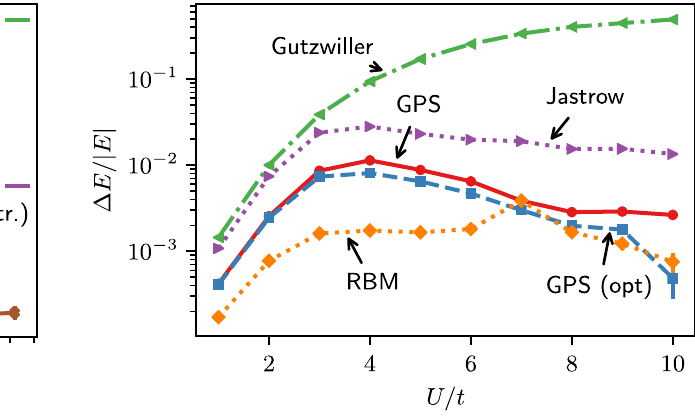
initial set of data configurations. For these data points, the p → ∞ limit of the kernel is used where the scaled distance weights f ð d Þ = θ in the kernel function are optimized variationally.